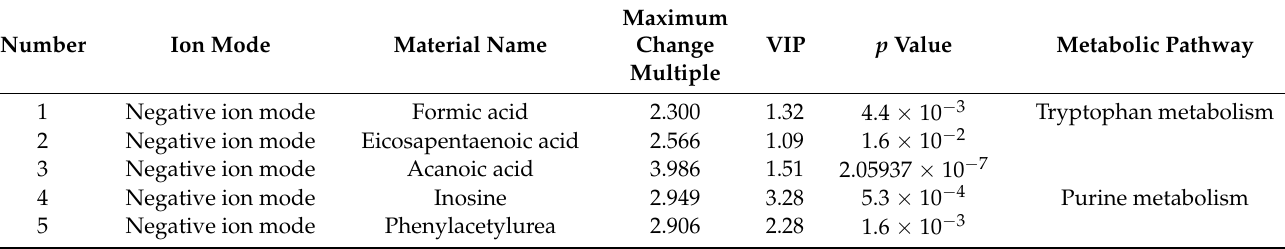
Figure 12. Volcano map of anions in the plasma of the study group and the control group. Abscissa is the change in the multiple of comparison between two groups of each substance, and ordinate is the P value of the t test, expressed by –logP. The point in the graph represents the metabolite, and the size of the point represents the size of the VIP value. Red dots represent ascending metabolites, blue dots represent descending metabolites, and gray dots represent undifferentiated metabolites. Table 3. Differential metabolites in anion